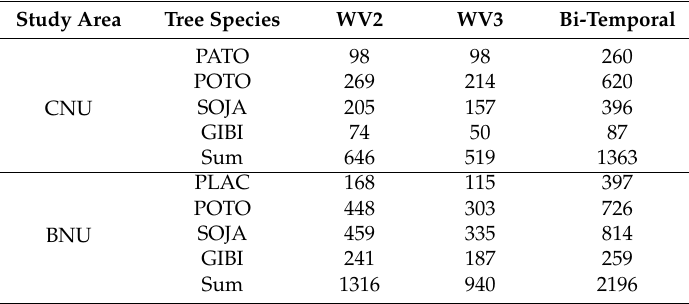
Table 6. Number of sample objects for each study